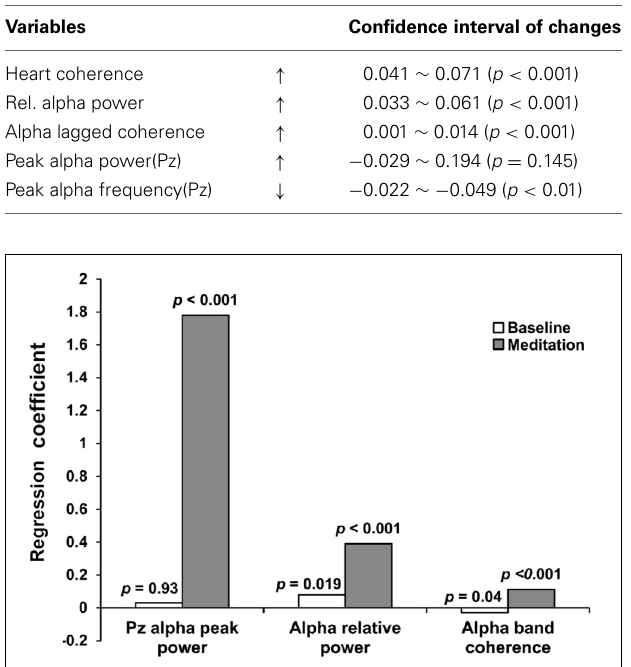
FIGURE 3 | Regression coefficients between heart coherence and EEG variables at baseline and during meditation for all participants. Significant correlations between heart coherence and alpha variables was observed during meditation, but not in baseline. Alpha relative power was significantly correlated with heart coherence both during meditation and baseline. Regression coefficients for all EEG alpha variables were greater in meditation than in